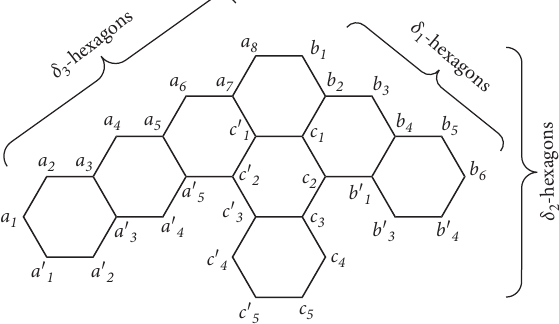
Figure 1: Benzenoid tripod with δ